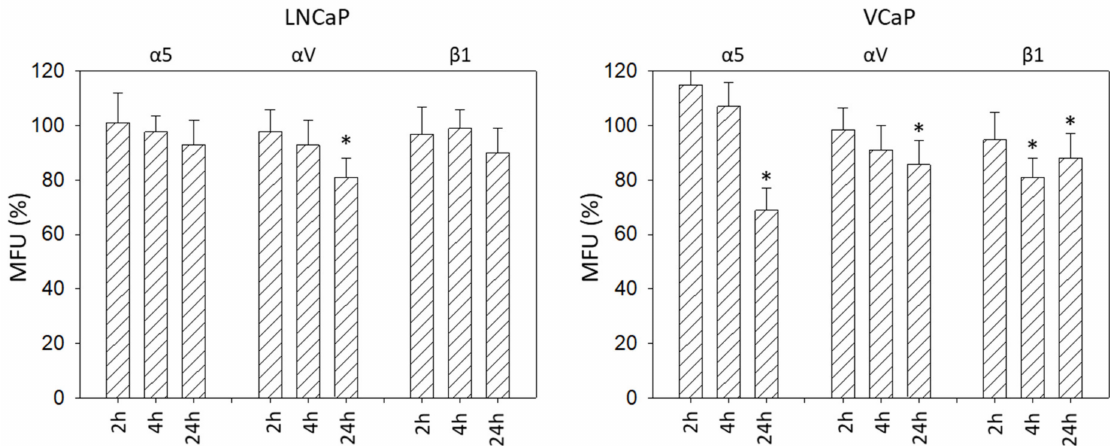
Figure 7. IGF-1 stimulated surface expression of the integrins α 5, α V, and β 1 on LNCaP and VCaP cells, evaluated after 2, 4, and 24 h. All values are related to untreated controls set to 100%. MFU: Mean fluorescence units. * indicates significant difference to controls ( n = 3).